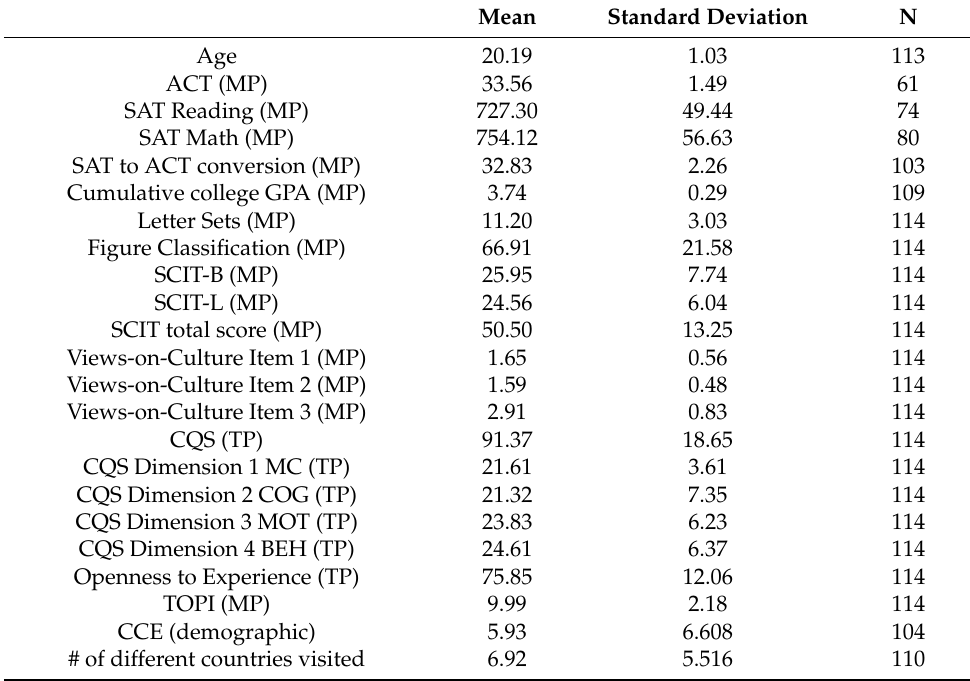
Table 1. Mean scores and standard